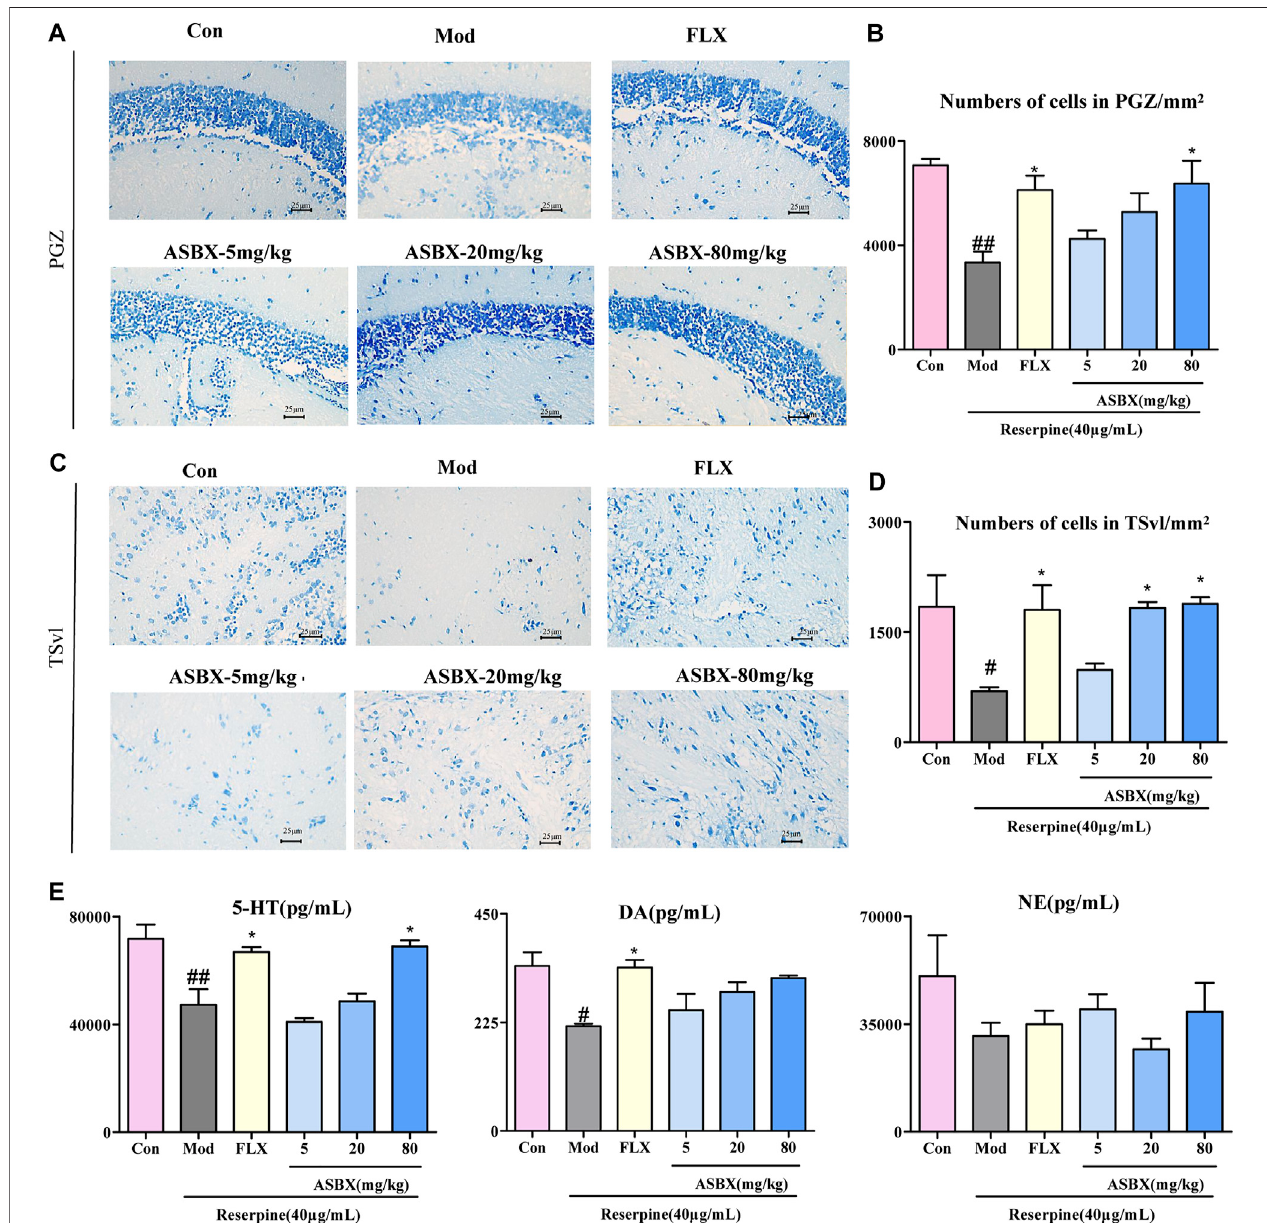
FIGURE 2 | ProtectiveeffectofAnshenBuxinSixPills(ASBX)onreserpine-inducedneuronalinjury. (A) .Nisslstainofzebra fi shbrain(400 × )inperiglomerulargrayzone(PGZ) (C) . Nisslstainofzebra fi shbraininventrolateralnucleusofthesemicirculartorus(TSvl). (BandD) arethequantitativestatisticsofneuronsinthePGZandTSvl,respectively. (E) .Thecontentof 5-HT, DA, NE in zebra fi sh brain was measured by ELISA. Data are expressed as the mean ± SEM (n (cid:1) 3/group). Signi fi cance was de fi ned as # p < 0.05, ## p < 0.01, * p < 0.05.